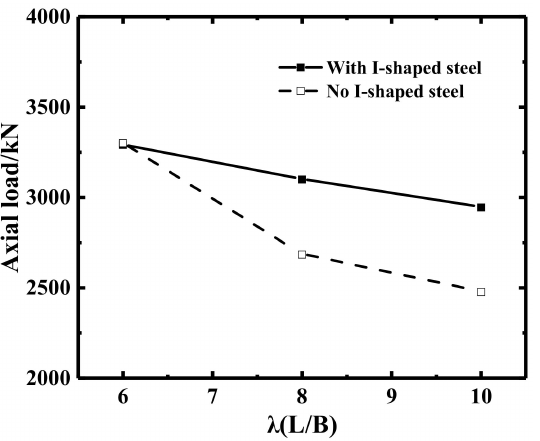
Figure 17. Variation of ultimate bearing capacity of specimens with different aspect ratios.